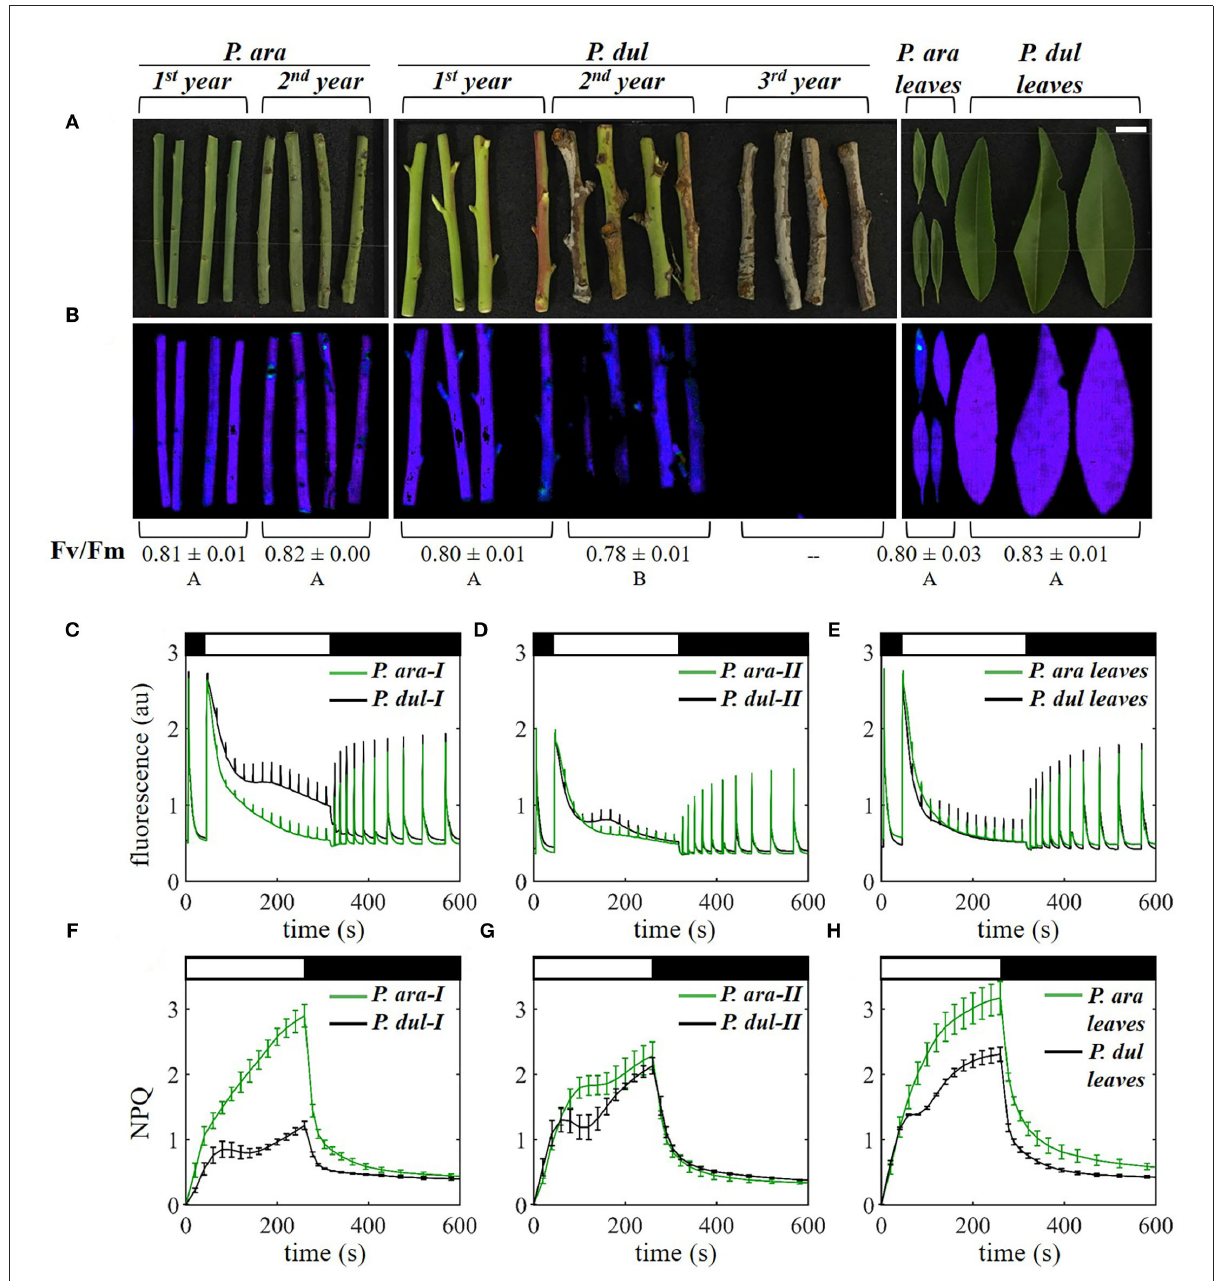
FIGURE5 Chlorophyll a fluorescence analysis of P. arabica and P. dulcis stems and leaves. (A) Images of 1 st and 2 nd -year stems of P. ara ; 1 st , 2 nd , and 3 rd -year stems of P. dul ; and leaves of the two species in May 2019. A scale bar = 1cm. (B) Corresponding fluorescence images depicting the maximum quantum yield of photosystem II (Fv/Fm) in false color. The mean Fv/Fm values ( ± SD) of the different stage branches and leaves are denoted below the images; Different letters indicate a statistically significant difference ( p < 0.05) for stems and leaves separately. (C–E) Maximum chlorophyll fluorescence (Fm’) induction curve analysis of (C) 1 st (I)-year stems, (D) 2 nd (II)-year stems, and (E) leaves, recorded in the morning following dark adaptation. Curves show the mean of 3-4 stems or leaves per group. (F–H) Non-photochemical quenching [NPQ, calculated as (Fm-Fm’)/Fm’] induction and relaxation of the same stages shown in (C–E) . NPQ curves shown are means ± SE ( n = 3-4 branches or leaves). Black/white bars at the top of the graphs indicate switching on and off the actinic light (a white bar = 530 µ mol photons m − 2 s − 1